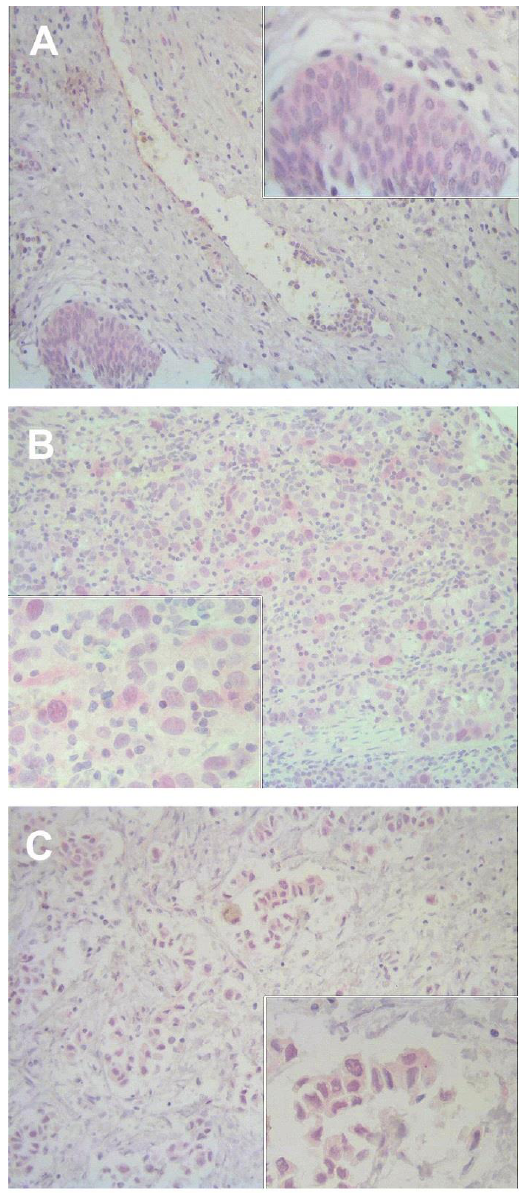
Figure 2. Immunohistochemical staining of Drosha in bladder tissue. Representative images show the expression of Drosha in non-malignant bladder tissue ( A ), in non-muscle-invasive pT1 tumor ( B ) and muscle-invasive pT3b tumor tissue ( C ). The staining of endothelial cells can be seen in ( A ). Magnification: 200×, inserts 400×.